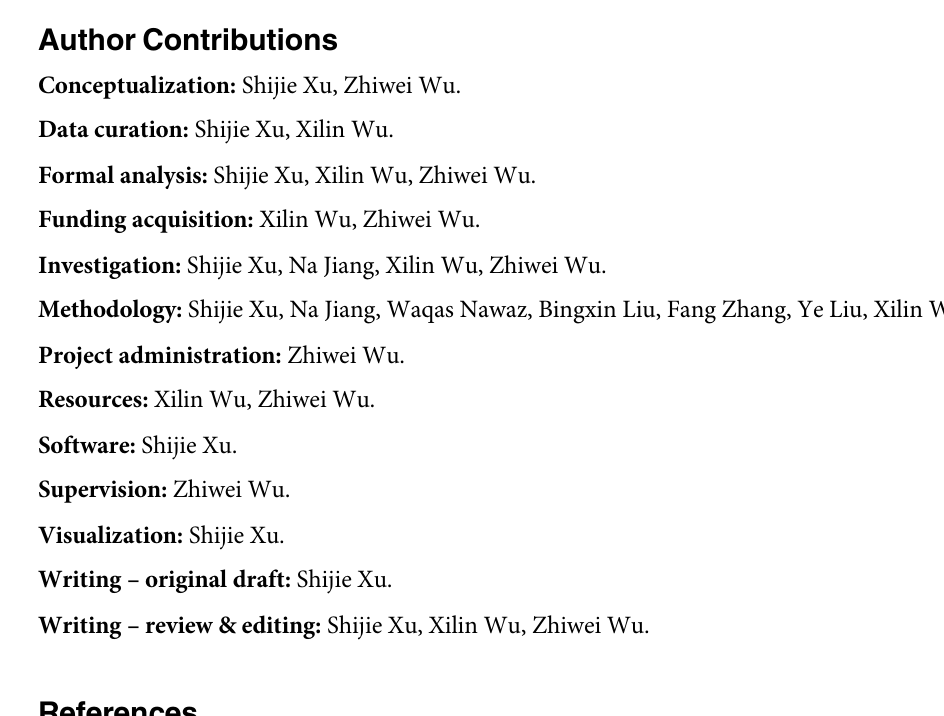
vitexicarpin treated. Data are shown as mean ± SEM of three independent experiments.